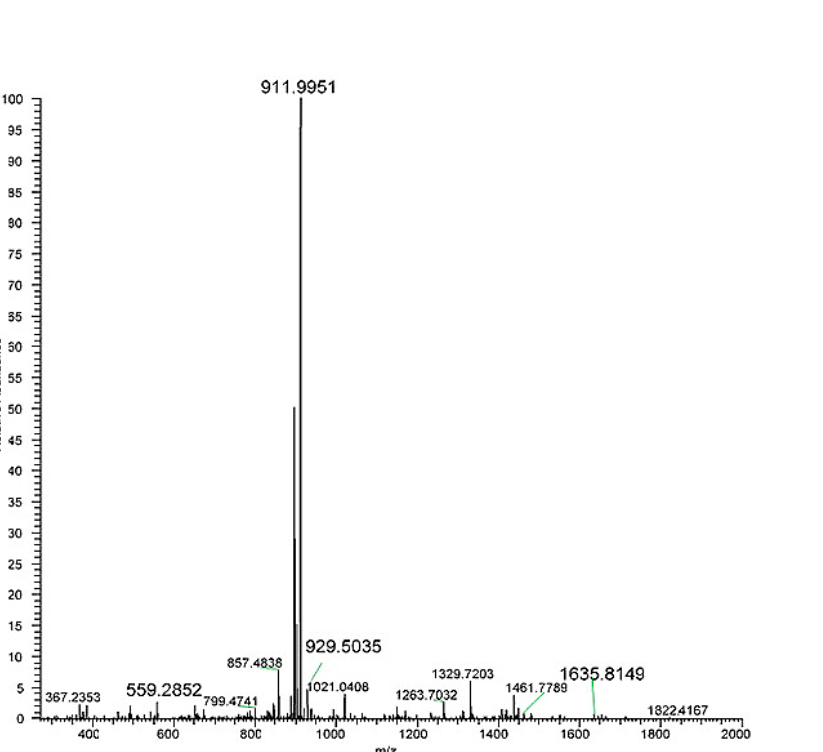
Figure A1. HRMS/MS spectrum obtained fragmenting the doubly charged ion of the mono-lactosylated peptide. Relative abundance is on the y axis, mass-to-charge ( m / z ) ratio on the x axis.